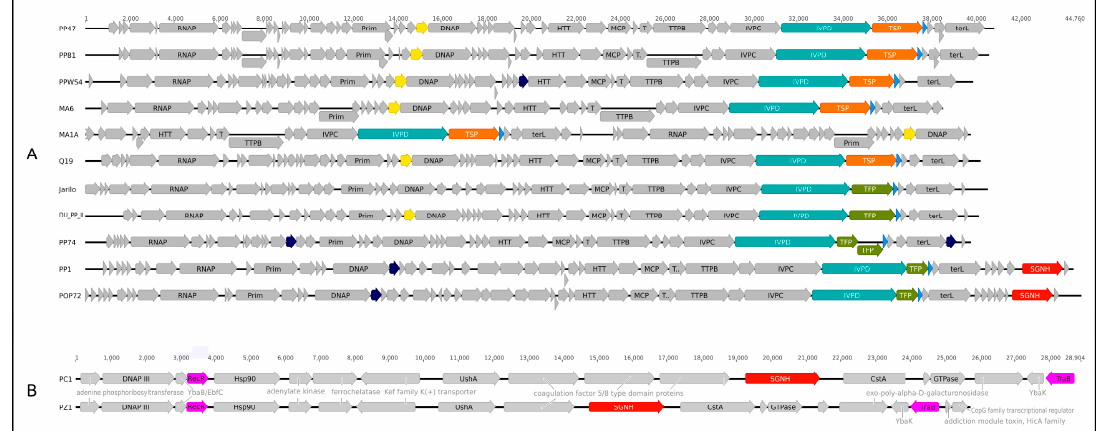
Figure 12. ( A ) Simplified genetic maps of Pectobacterium Studiervirinae phages PP47, PP81, PPWS4, MA6, MA1A, Q19, Jarilo, DU_PP_II and PP74, and phages PP1 and POP72. ( B ) Regions of Pectobacterium aroidearum PC1 and Pectobacterium polaris PZ1 containing the genes of SGNH-domain proteins, homologous to Q19 and PP47/81 tail spike proteins. The colors of different genes are as follows: orange, tail spike protein; green, tail fibre protein; cyan, tail tubular protein B; blue, holin; dark-blue, HNH endonuclease; yellow, nucleotidyltransferase; purple, recombination protein RecR and conjugal transfer protein TraB; grey, other genes. Putative functions of genes are given according to Genbank annotations and BLAST search (Tables S6–S8).